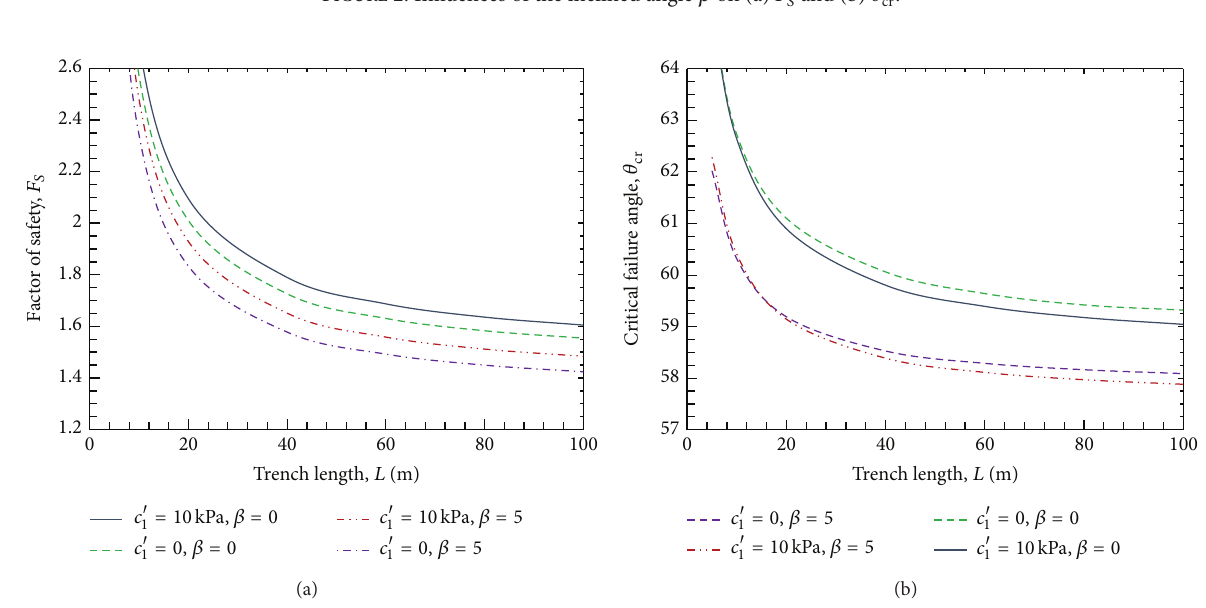
Figure 3: Influences of the trench length 𝐿 on (a) 𝐹 𝑆 and (b) 𝜃 cr